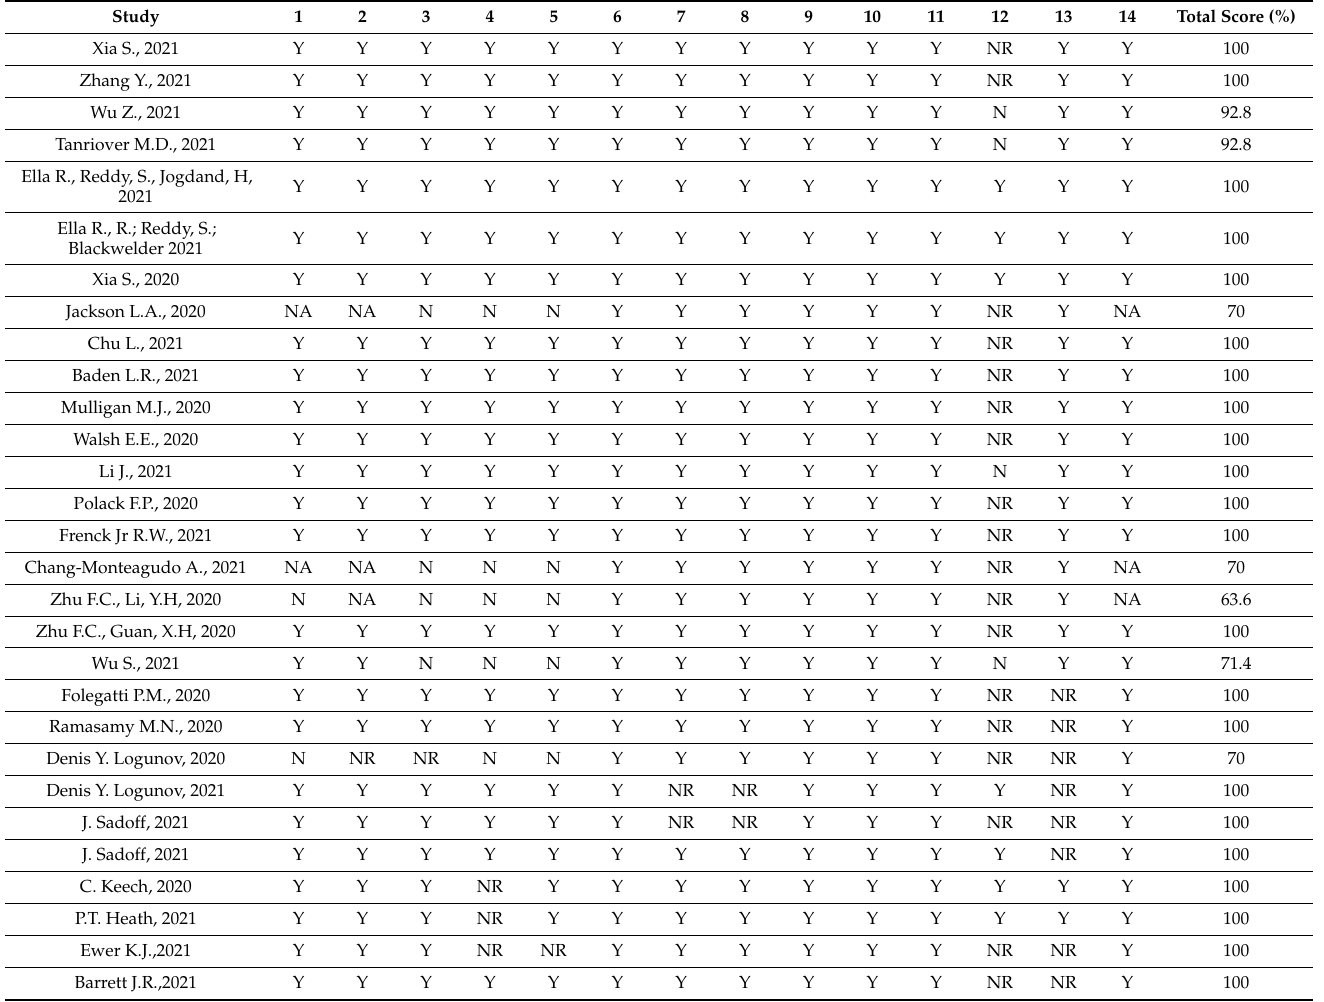
Table 1. Quality assessment of the selected studies of clinical trial